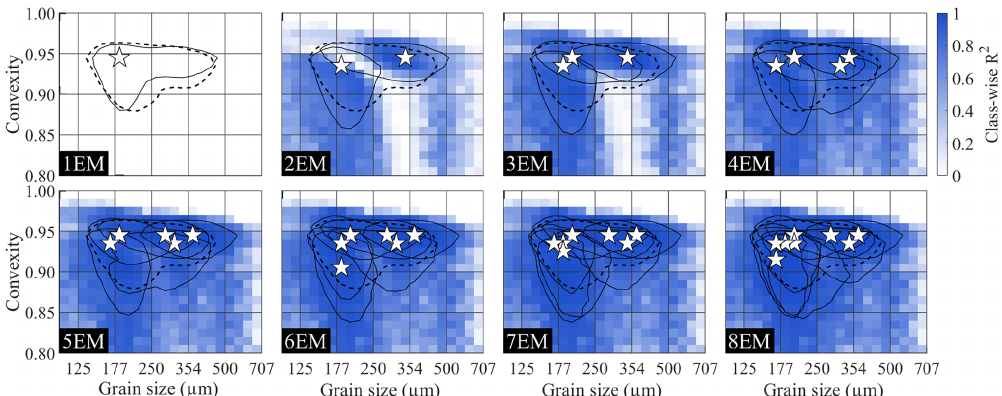
Figure 9. Class-wise R 2 for endmember modelling results of the ConD2d distributions of the aeolian dune dataset. All solutions up to eight endmembers are shown. Solid black lines denote endmember contours: lines drawn along those size–shape classes where the volume of the endmember SSD equals 0.5%. The median SSD of the dataset (average SSD) is represented by a dashed line at 0.2% volume. White stars denote the modes of the endmember size–shape